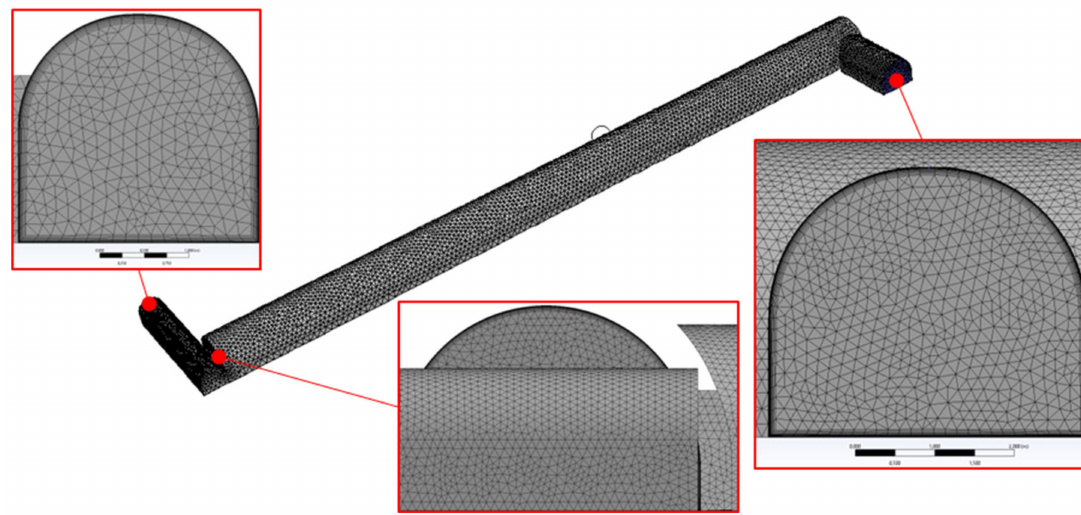
Figure 7. Numerical grid of the underground working.